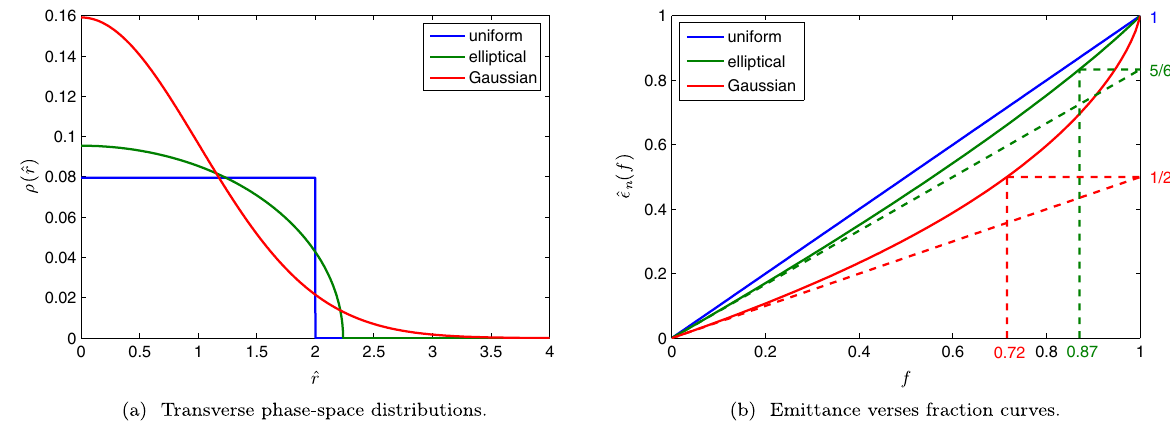
FIG. 19. Example transverse phase-space distributions as a function of the normalized coordinates ^ r 2 ¼ ^ x 2 þ ^ p 2 x (a), and the corresponding emittance vs fraction curves (b). Dashed lines indicate core emittance and core fraction values.